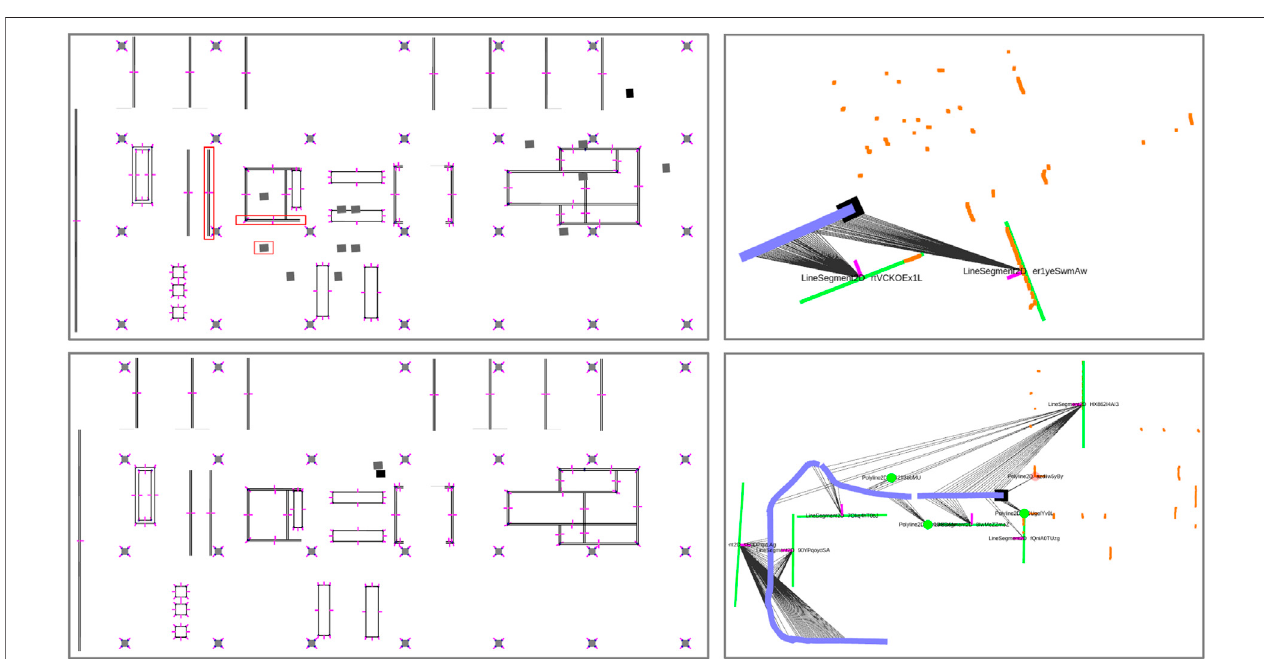
FIGURE10| Thetopleftmapshowstheglobalhypothesesthatarecreatedbasedonthelocalmapatthetopright.Thecorrecthypothesisandfeaturepairingsare indicatedbyredsquares.ThelocalmapshowstheLiDARpointsinorangeandthelocalmapingreen.Thebottom fi guresshowtheglobalandlocalmapafterlocalization is achieved. The ML hpyothesis is show in black a number of back-up hypothesis in grey. One of them is signi fi cantly drifted because of a different assumption made recently. The others are covered by the ML hypothesis.